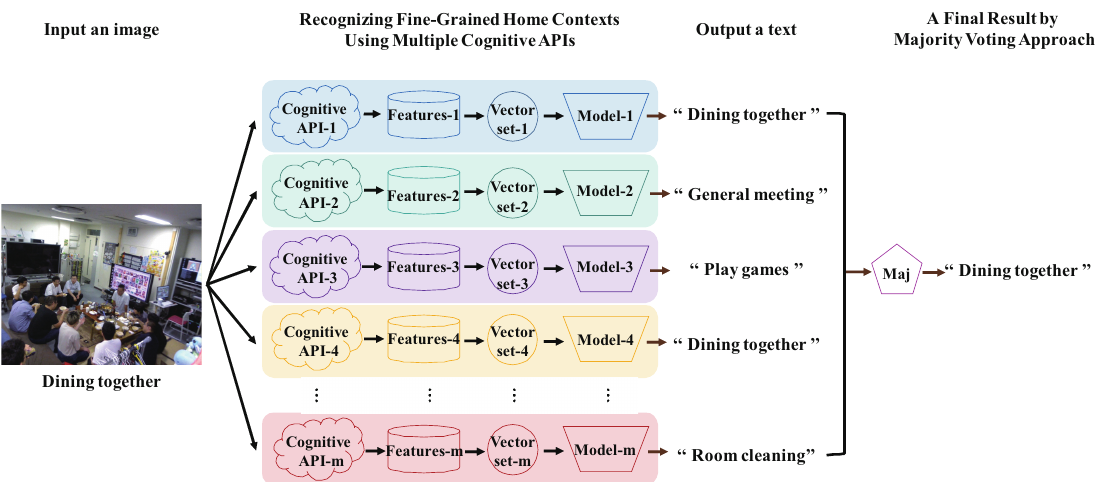
Figure 2. Example of recognizing an image using multiple cognitive APIs and majority